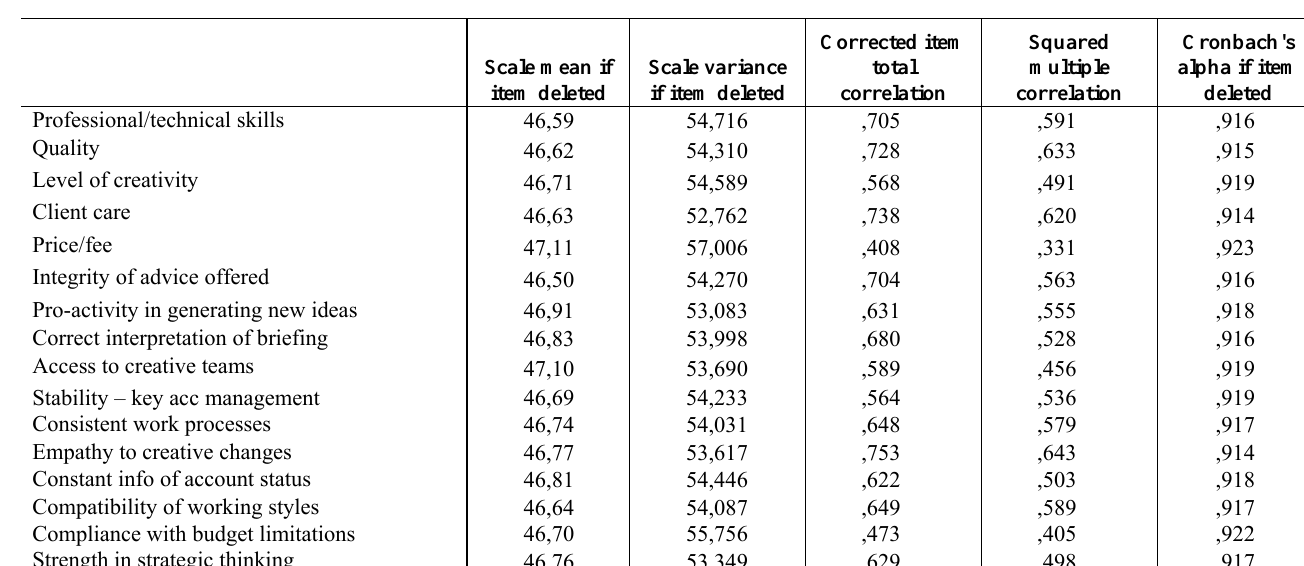
Table 2: Client satisfaction: Item total